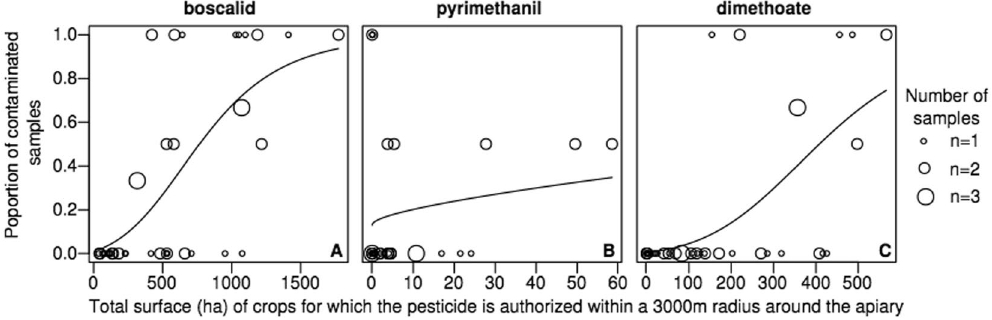
Figure 3. Observed proportion of samples contaminated for each pesticide and the corresponding predicted value (binomial GLM) relative to the areas of authorized crops around the apiary.